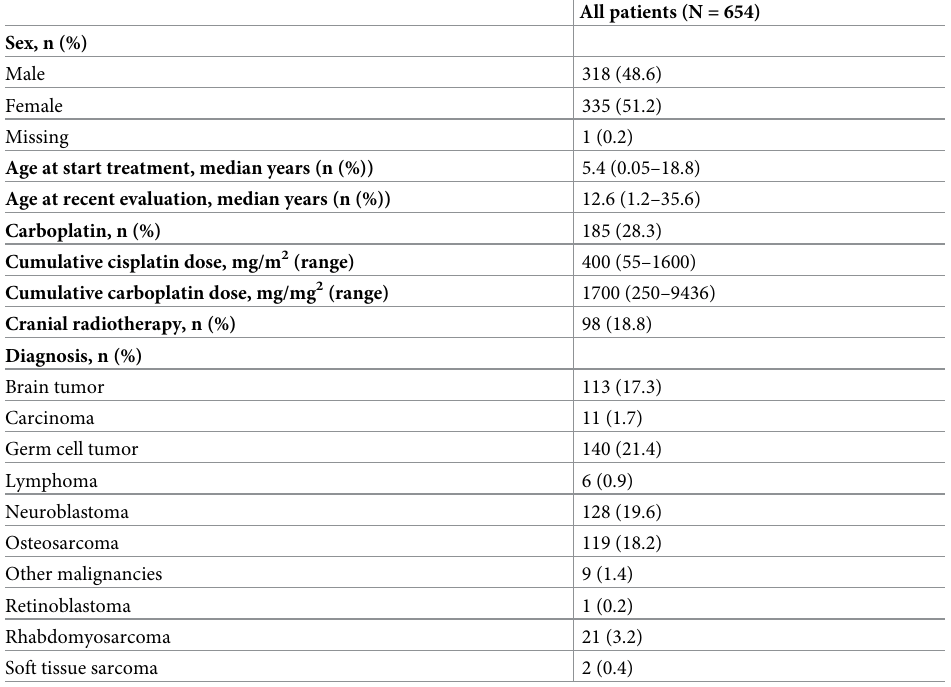
Table 2. Baseline characteristics of included